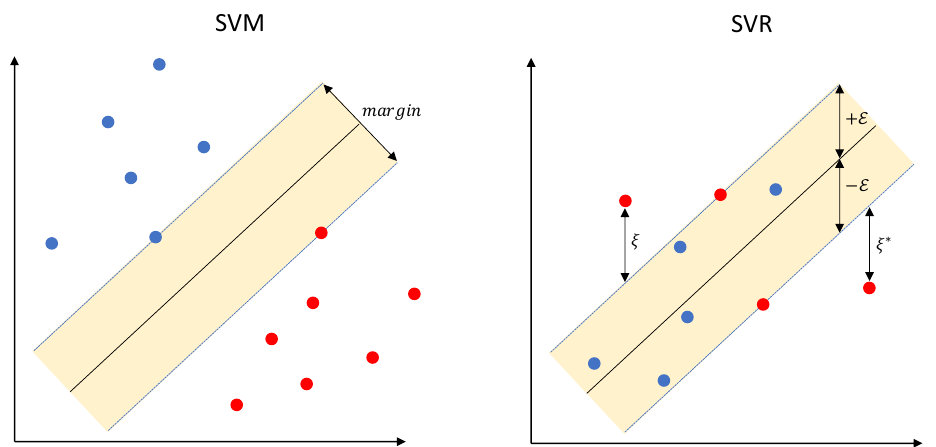
Figure 4. Examples of the one-dimensional SVM and SVR model.